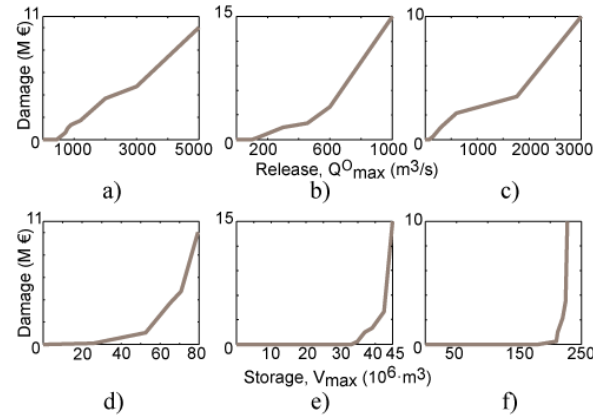
Fig. 6. Damage vs. maximum release (a, b, c) and damage vs. max- Figure 6 . Damage vs. maximum release (a, b, c) and damage vs. maximum volume stored (d, 790 imum volume stored (d, e, f) , for the three case studies: Puentes (a, e, f), for the three case studies: Puentes (a, d), Talave (b, e), and Fuensanta (c, f) 791 d) , Talave (b, e) , and Fuensanta (c, f)